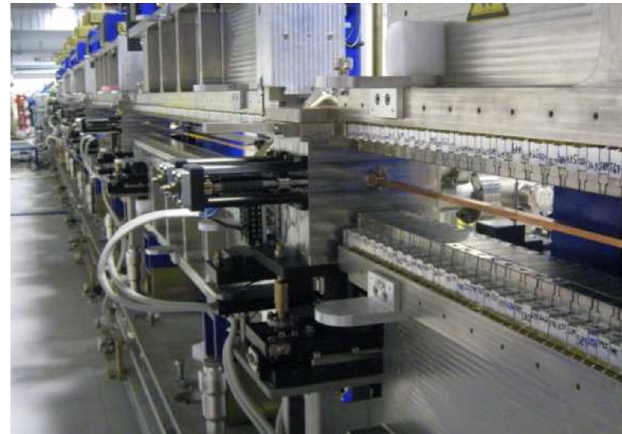
1. General SPARC layout. (A) High-brightness rf gun (BNL/UCLA/LCLS design). (B) Linac, composed by three traveling wave-type accelerating sections. (C) Transfer